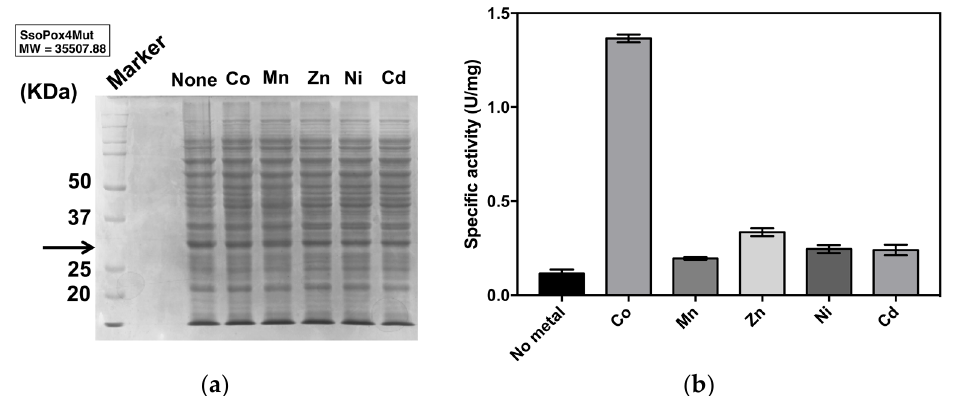
Figure 2. Metal ions analysis for the enhancement of paraoxonase activity of Sso Pox 4Mut. ( a ) SDS-PAGE of crude extracts. The band derived from the expression of 4Mut is indicated by the arrow. ( b ) Paraoxonase activity of 4Mut without metal or in the presence of different kind of metal including cobalt, manganese, zinc, nickel and cadmium. Assays were performed using crude extracts .